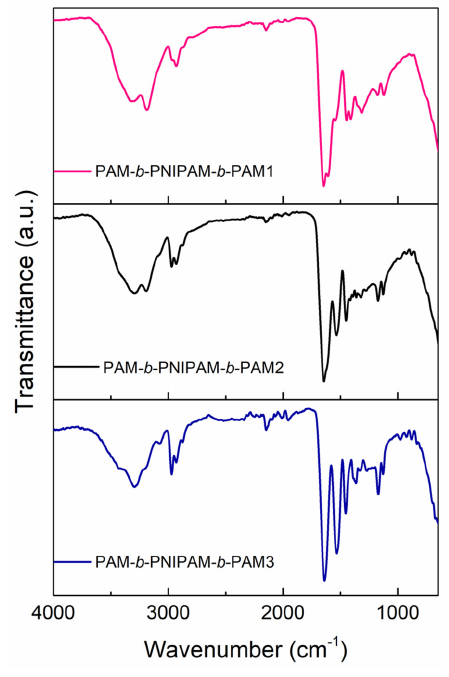
Figure 2. FT-IR spectra of the triblock copolymers: PAM − b − PNIPAM − b − PAM1, PAM − b − PNIPAM − b − PAM2, and PAM − b − PNIPAM − b − PAM3. The representative chemical shift signals of both blocks, PAM and PNIPAM, are shown by the uppercase and lowercase le tt ers, as seen in Figure 3. The 1 H NMR spectra show that the intensity of the signals were proportional to the PAM block and NIPAM monomer feed. This con fi rms that the triblock copolymers had a di ff erent chemical composition due to the variation of the length of both blocks.